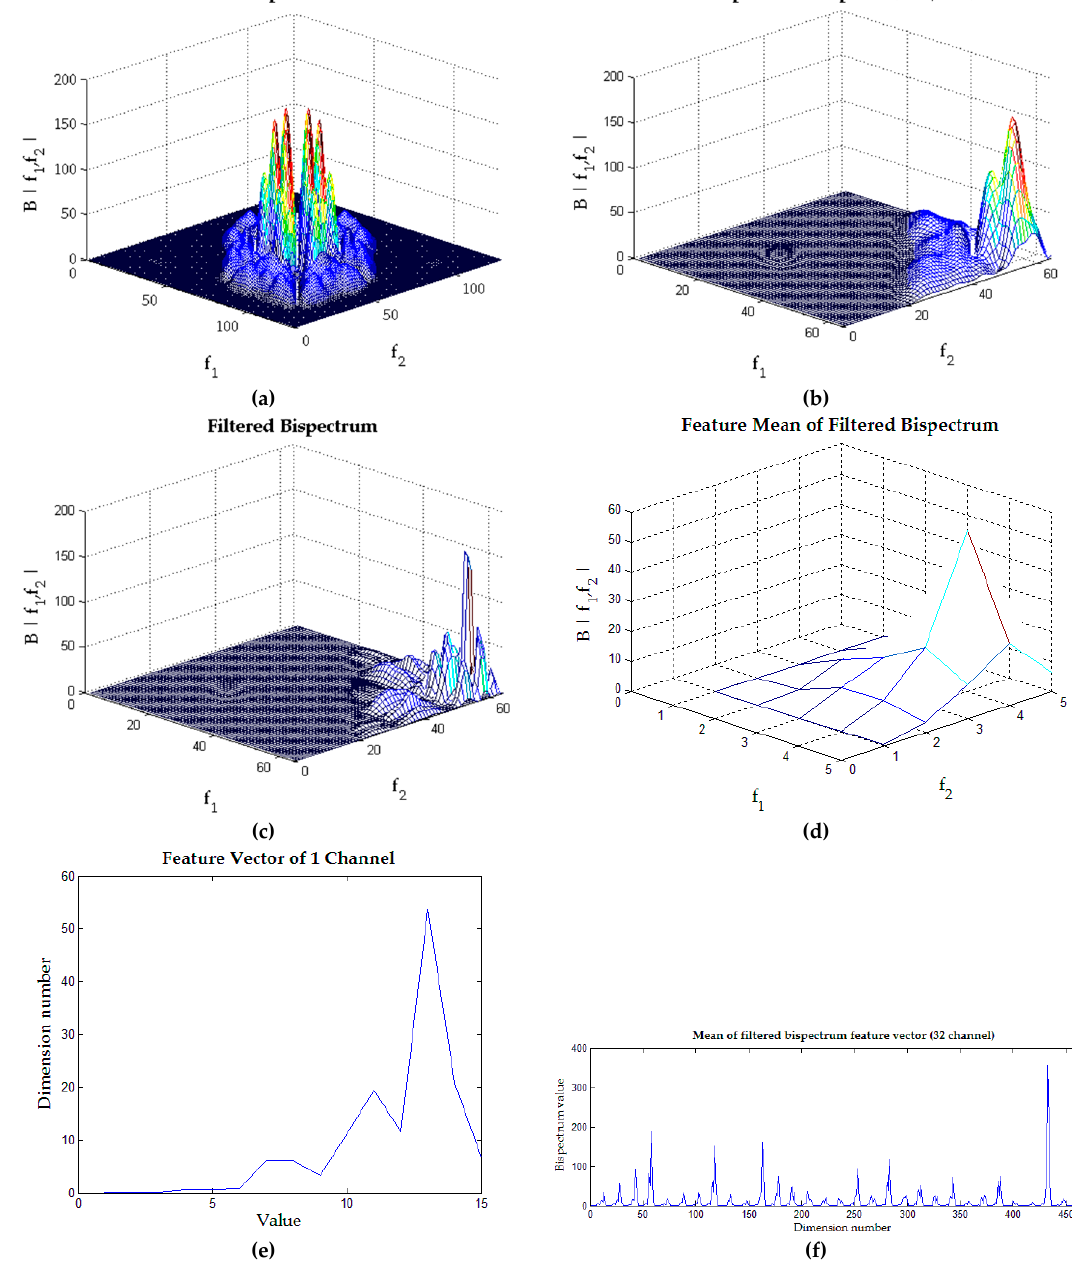
Figure 4. Bispectrum filtering step: ( a ) the original bispectrum contour plot, ( b ) one-quarter of the bispectrum matrix, ( c ) the result of the filtering process, ( d ) the mean as the feature, ( e ) the feature vector constructed from the non-redundant region of the quantized matrix and ( f ) the full feature vectors from the 32 channels.